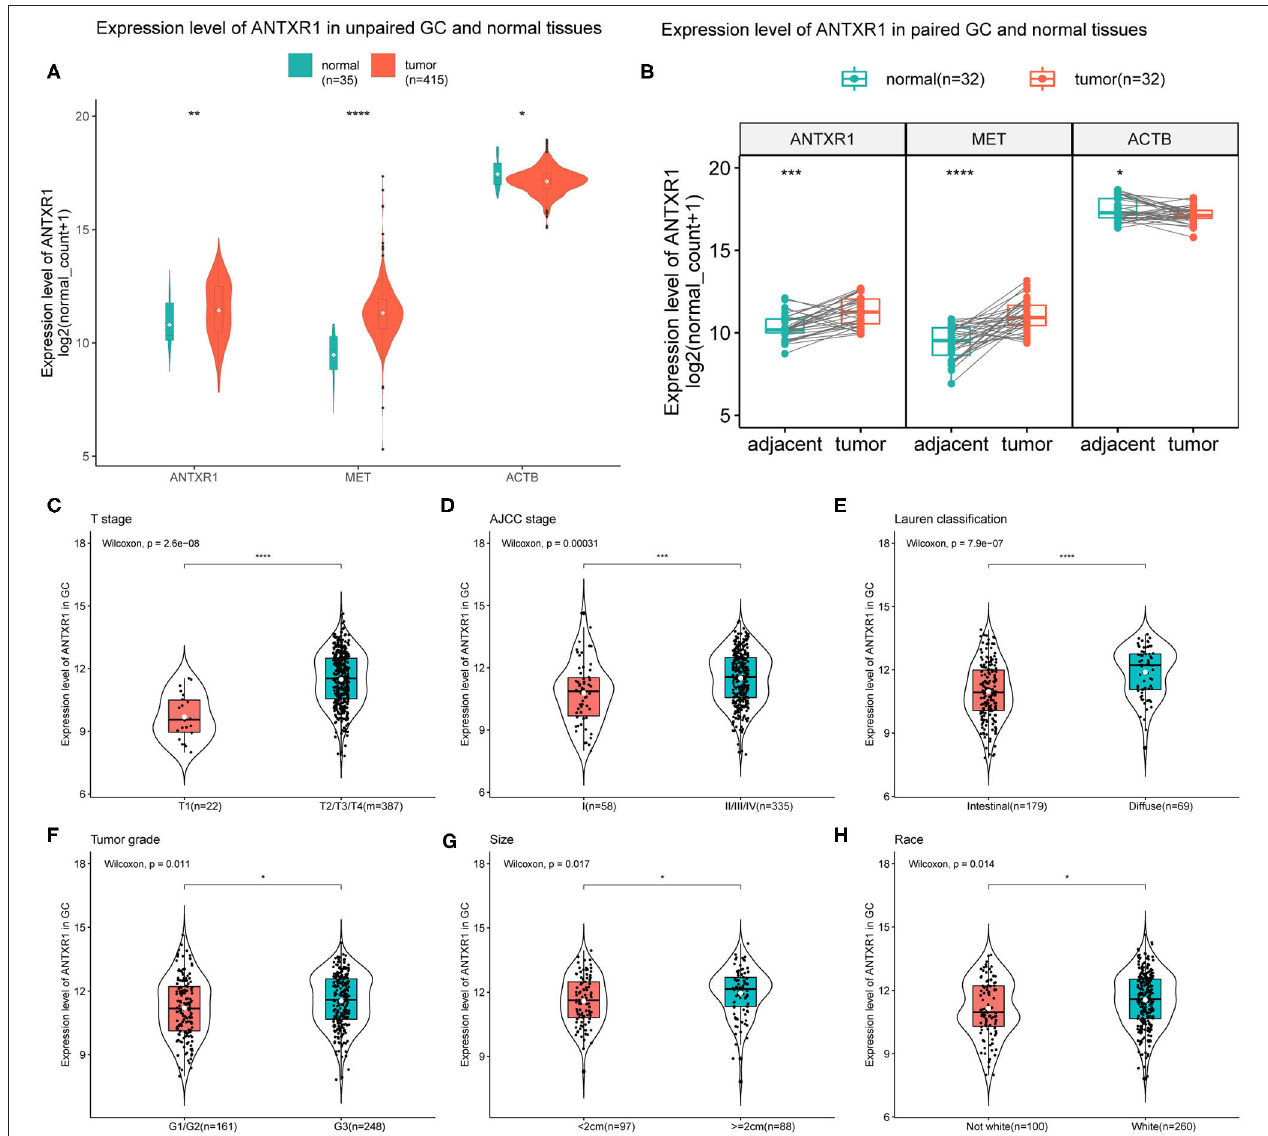
FIGURE 1 | Elevated expression level of ANTXR1 correlated with aggravation of gastric cancer. (A) Expression level of ANTXR1 in unpaired tumor and adjacent tissues. (B) Expression level of ANTXR1 in unpaired tumor and adjacent tissues. MET and ACTB gene expression were considered as positive and negative control, respectively. (C–H) Comparisons of ANTXR1 expression levels in different clinical features in GC. (C) T stage, (D) AJCC stage, (E) Lauren classification, (F) histological grade, (G) tumor size, and (H) race. Box plots elements (center line, median; box boundaries, upper and lower quartiles; whiskers, maximum and minimum). * P < 0.05, ** P < 0.01, *** P < 0.001, **** P <